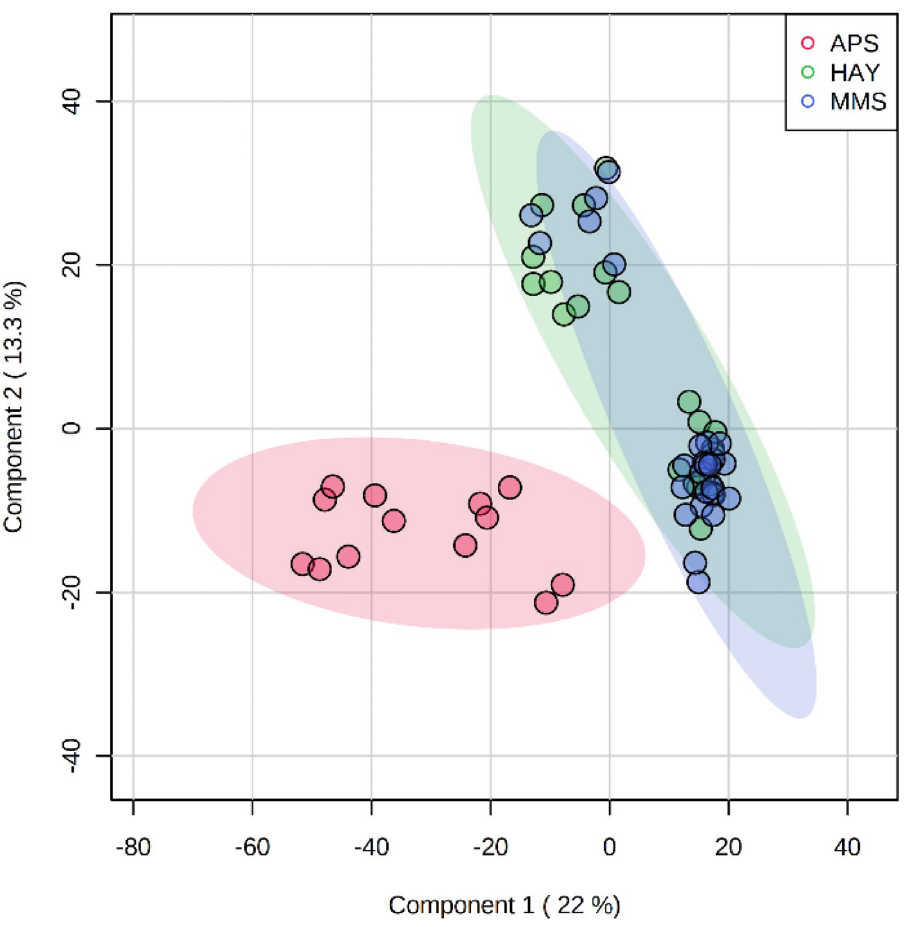
Figure 2. PLS-DA scores plot based on (+ / −) DART-HRMS metabolites on the train set (n = 63). Ninety-five percent ellipses confidence intervals (0.95-CI) are drawn around each centroid of groupings. MMS , mix crop/ maize silages (blue circles); HAY , permanent meadow and lucerne hays (green circles); APS , Alpine pasture (red